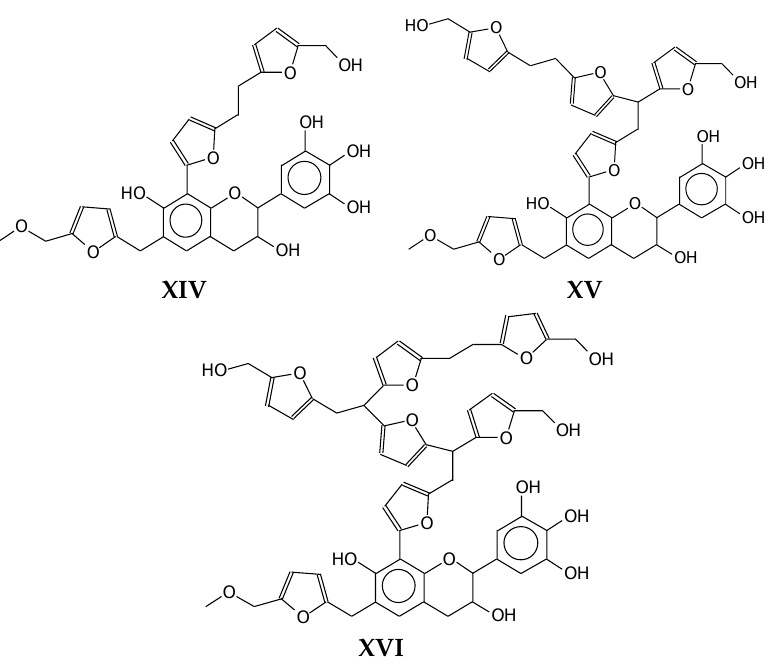
Scheme 8. Examples of structures produced in the foams coreaction showing that flavonoid monomers and oligomers do react with complex oligomeric humins structures.